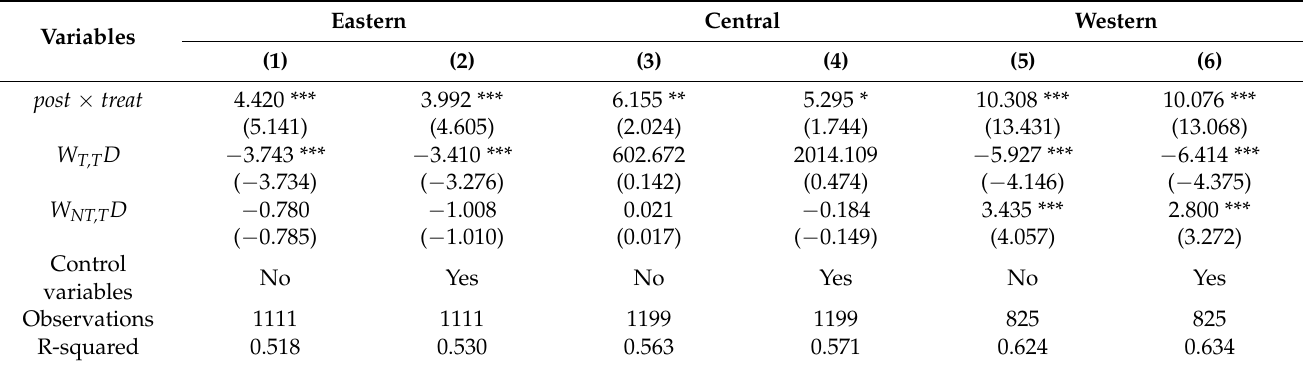
Table 6. Regional heterogeneity results of the SDID